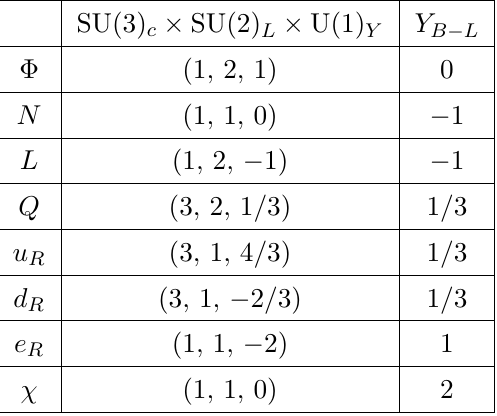
Table 1. Particle content and there corresponding